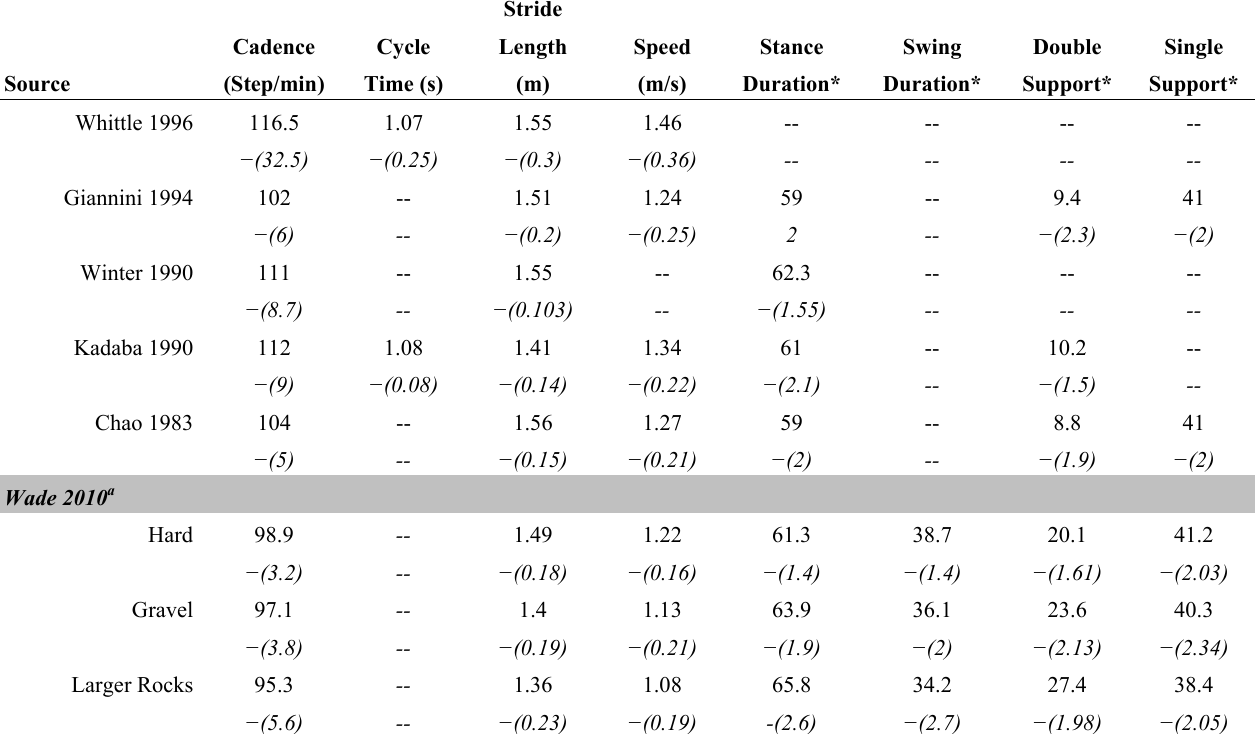
Table 1. Temporal spatial parameter comparisons for irregular surfaces and select datasets published in the